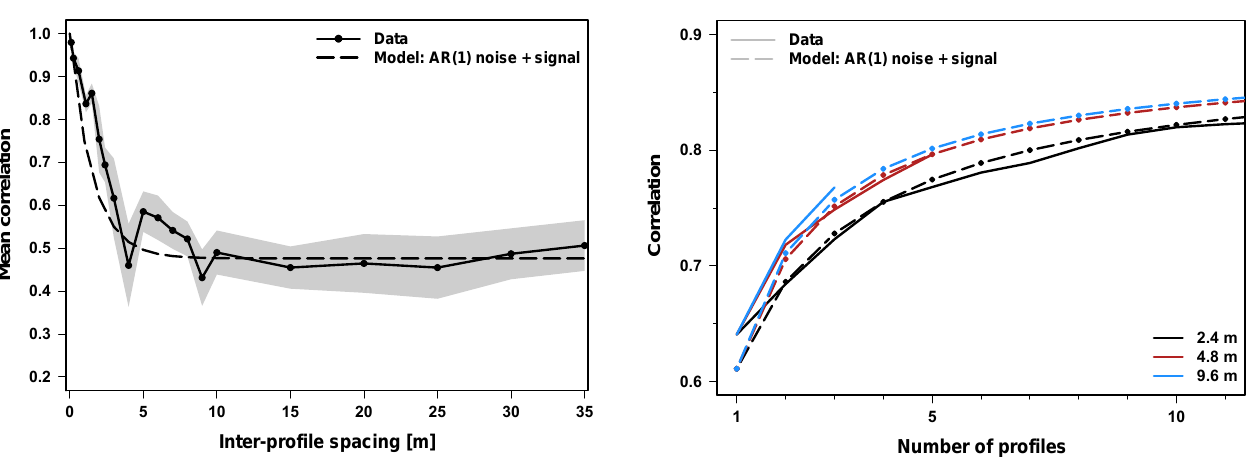
Figure 7. Observed and modelled correlations between T1 profile stacks and the mean of all T2 profiles depending on the number of profiles in the T1 stack for three selected inter-profile spacings. Observed results for given spacing and number of profiles are the mean across the correlations obtained for all possible unique stacks and only calculated when at least 15 stacks are